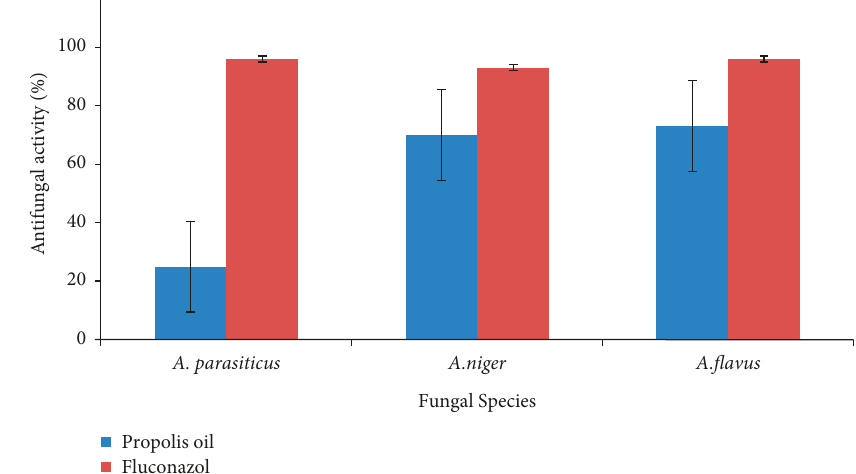
Figure 2: Antifungal activity of propolis oil against fungal species.